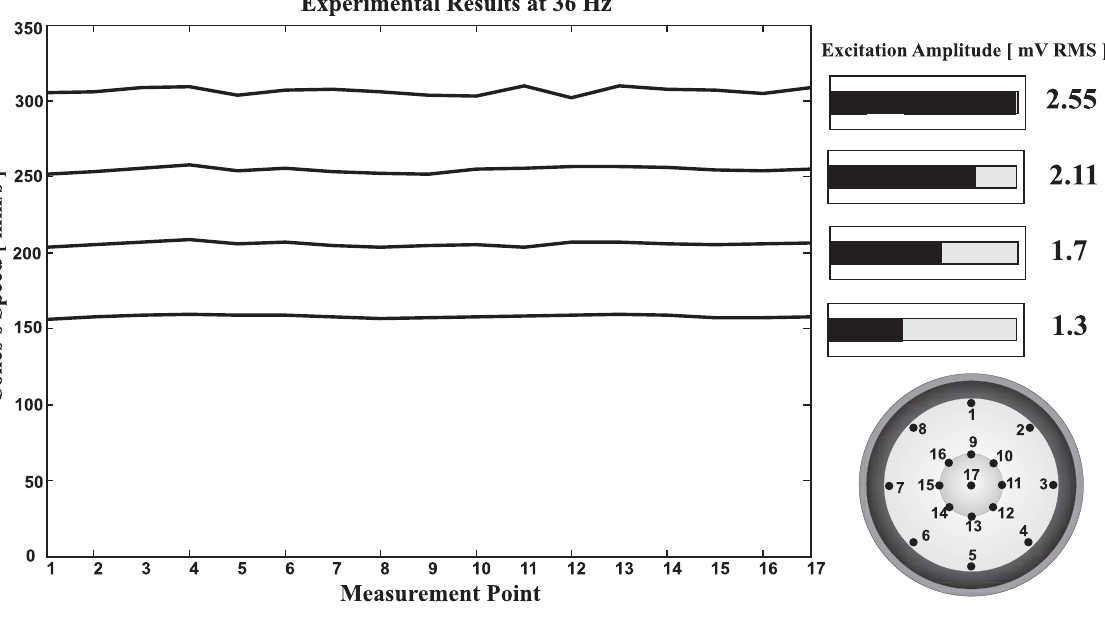
Fig. 9. Experimental speed measurements of the speaker’s cone at 36.132